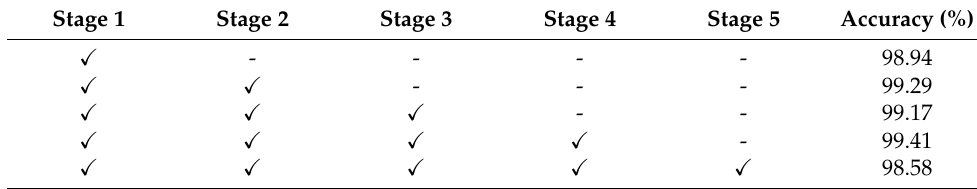
Table 8. Results of the ablation